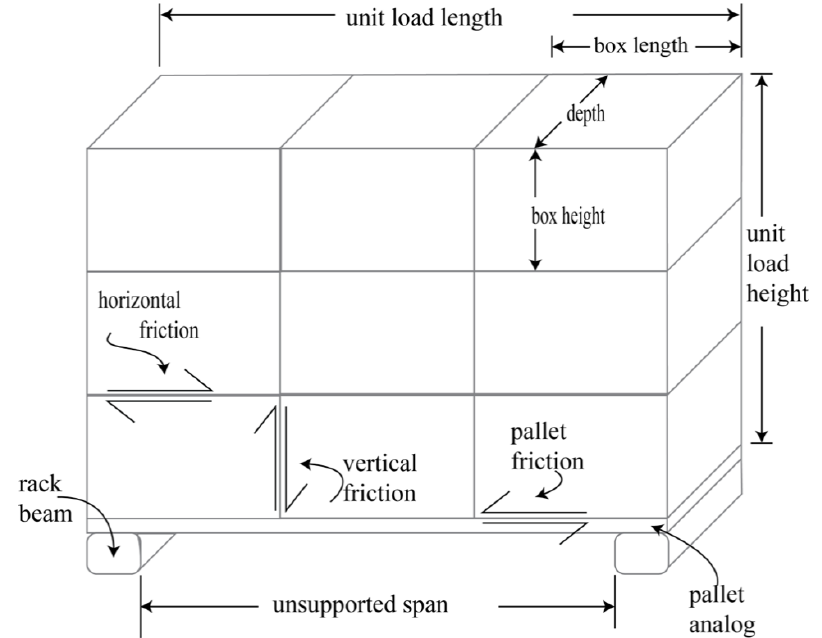
Figure 2. Diagram of the unit load segment modeled.